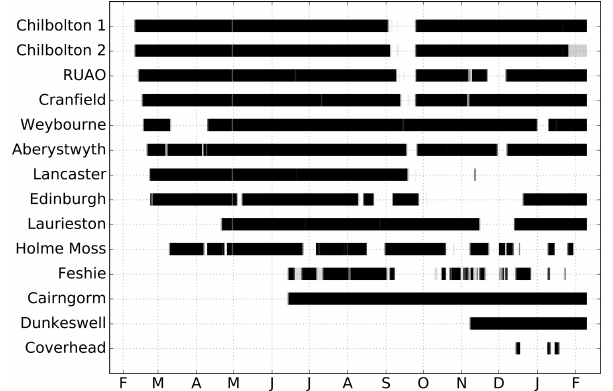
Figure 5. Daily upload performance of DiVeN in the first 365d of operation. Black indicates 100% upload (1440 files in a day), and white indicates 0% upload.